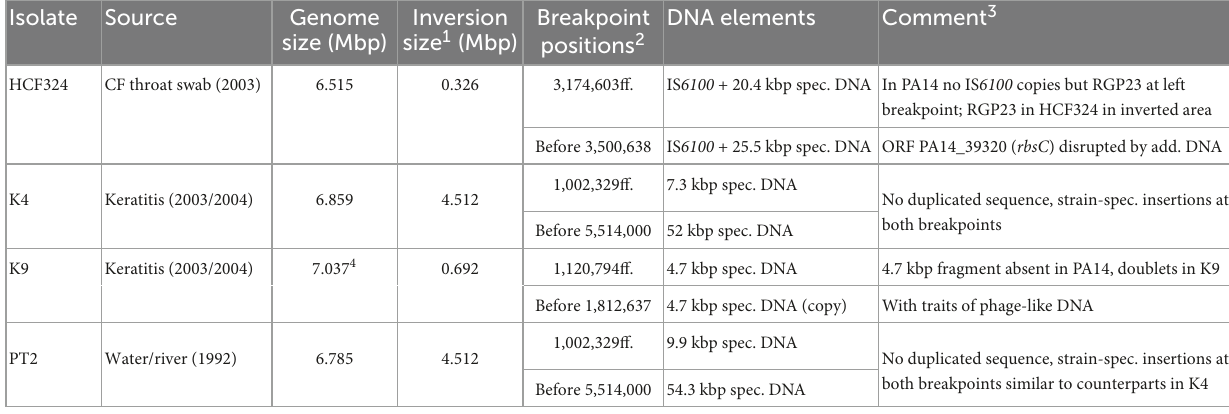
TABLE 4 Inversions in clone PA14